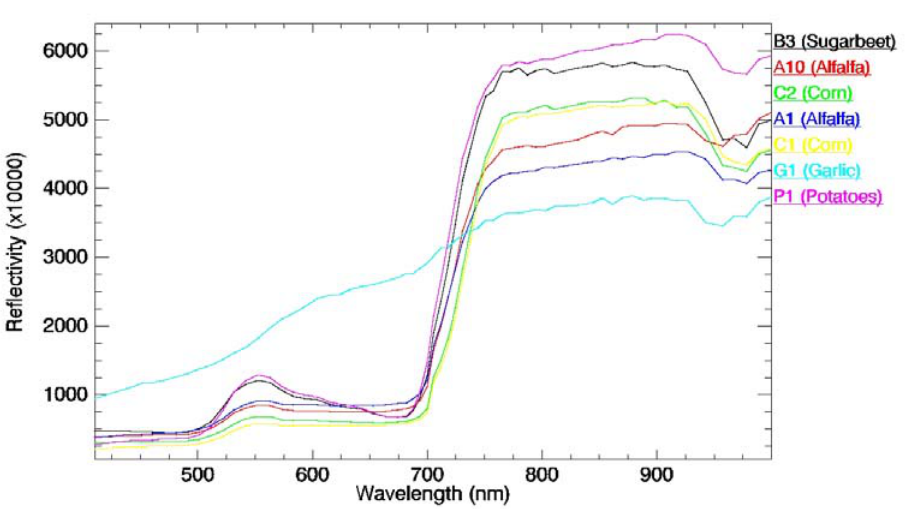
Figure 5. At-surface reflectivity spectra extracted from CHRIS image for the different samples (see Table 1).